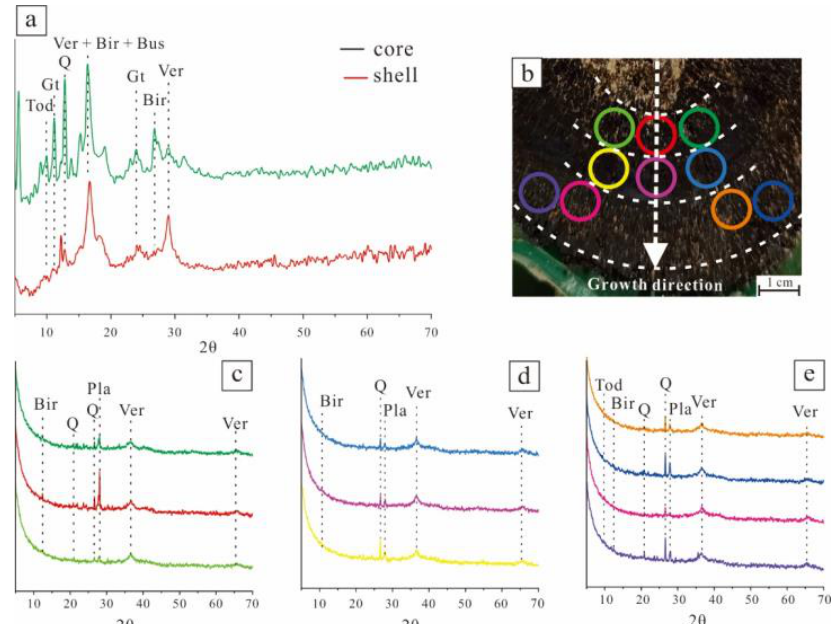
Figure 4. X-ray diffraction of the core and shell of polymetallic nodules. ( a ) XRD of the core and shell; ( b ) sampling position of XRD in polymetallic nodules; ( c ) XRD of the loose layer (inner); ( d ) XRD of the dense layer; ( e ) XRD of the loose layer (outer). Gt — goethite, Q — quartz, Ver — vermiculite, Bir — birnessite, Bus — bustamite, Pla — Plagioclase, Tod-todorokite.